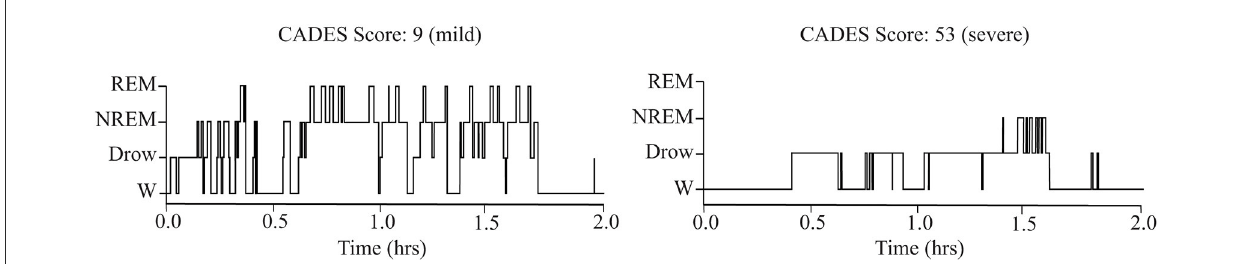
FIGURE3 Representative hypnograms showing the difference in sleep architecture between a dog with mild (left) and severe (right) cognitive impairment based on CADES score. W, wakefulness; Drow, Drowsiness.